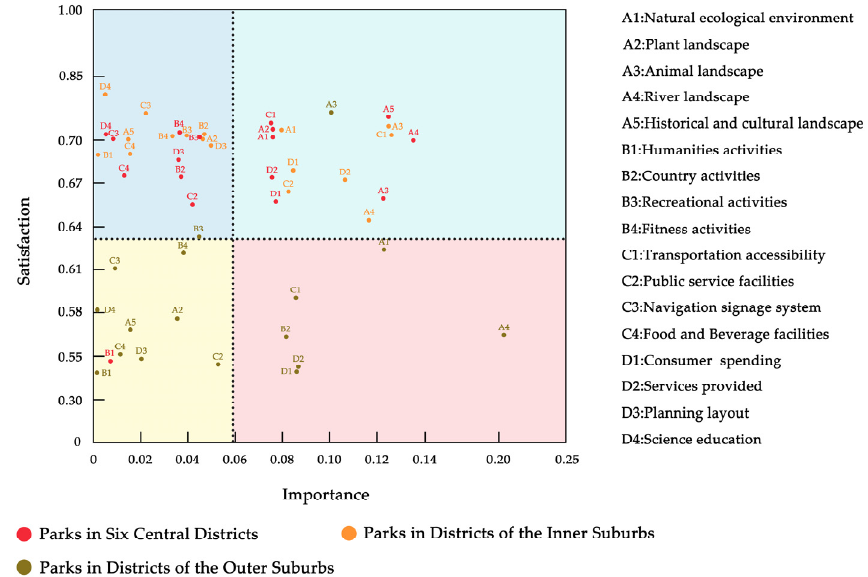
Figure 12. IPA model of riverside parks in different districts based on spatial landscape design.